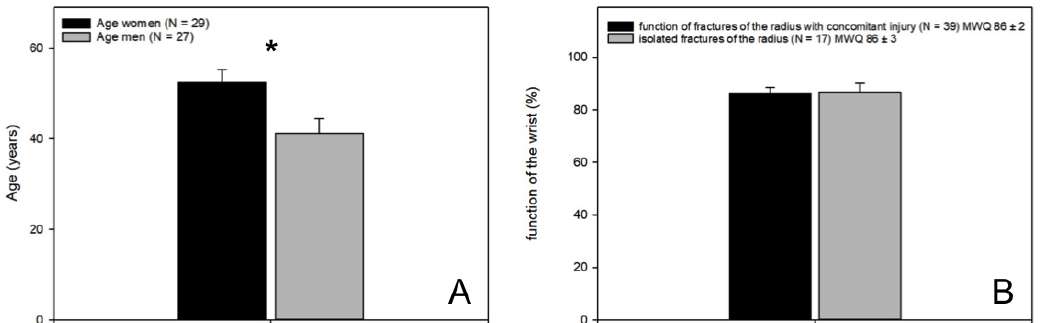
Figure 4. Age distribution and function. ( A ) The female collective was significantly older than the male patients; ( B ) no difference in function of the wrist could be detected according to the self-assessment score (MWQ) between fractures with arthroscopically treated concomitant injuries and isolated fractures of the distal radius (86% ± 2% vs. 86% ± 3%, mean ± SEM). Table 1. Fracture classification and concomitant